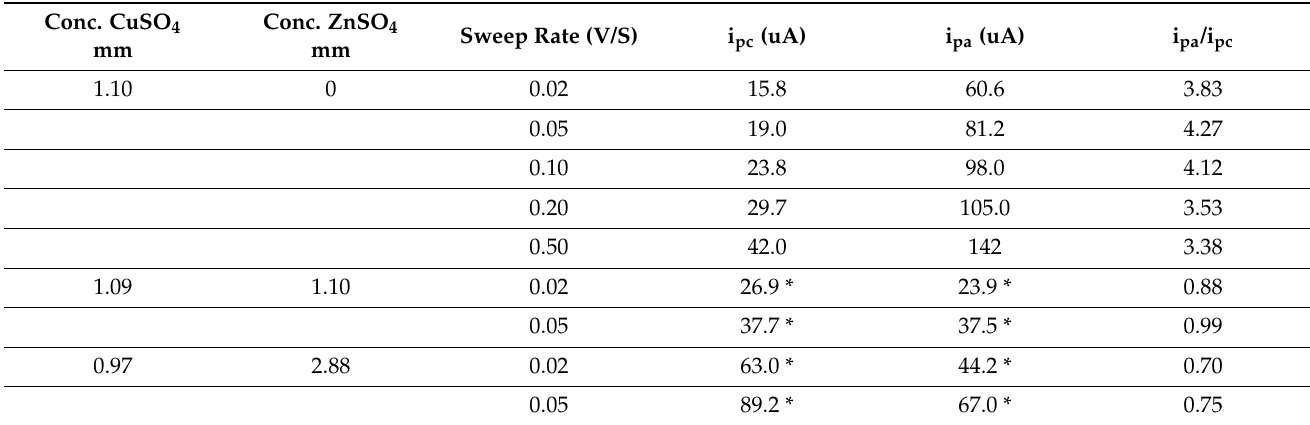
Figure 1. 0.97 mm CuSO 4 and 1.94 mm ZnSO 4 in a 0.1 M K 2 SO 4 glassy carbon working electrode. No GQD in the medium. Table 2. The cyclic voltammetry features of copper sulfate and zinc sulfate in 0.1 M K 2 SO 4